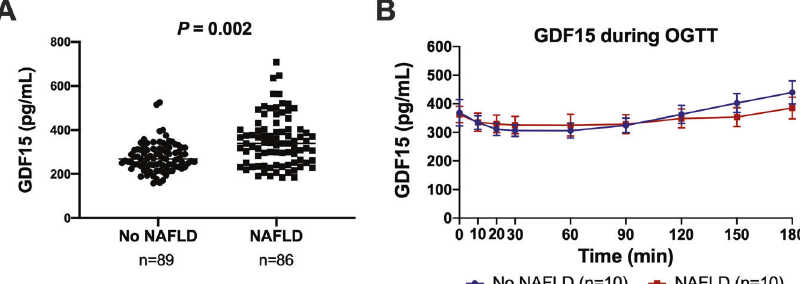
Fig. 1 GDF15 in a cross-sectional cohort of youth with and without NAFLD. A Fasting plasma GDF15 concentration in overweight/obese youth with or without NAFLD. P -value is from Mann – Whitney test. B Plasma GDF15 levels during an OGTT in overweight/obese youth with and without NAFLD, matched for age, sex, ethnicity, BMIz. Youth without NAFLD are depicted in blue and youth with NAFLD are depicted in red. Differences in GDF15 concentrations during an OGTT between the groups were not statistically signi fi cant. Error bars represent standard error of the mean.